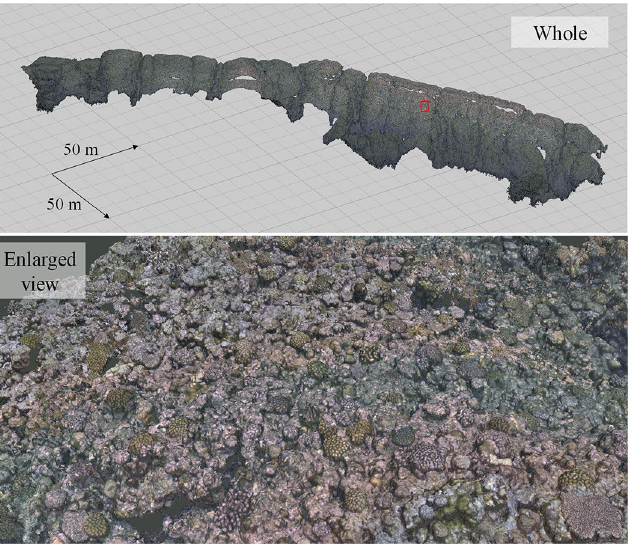
Figure 2. 3-D structure model: the top is a whole view and the bottom an enlarged view of the inside of the red rectangle